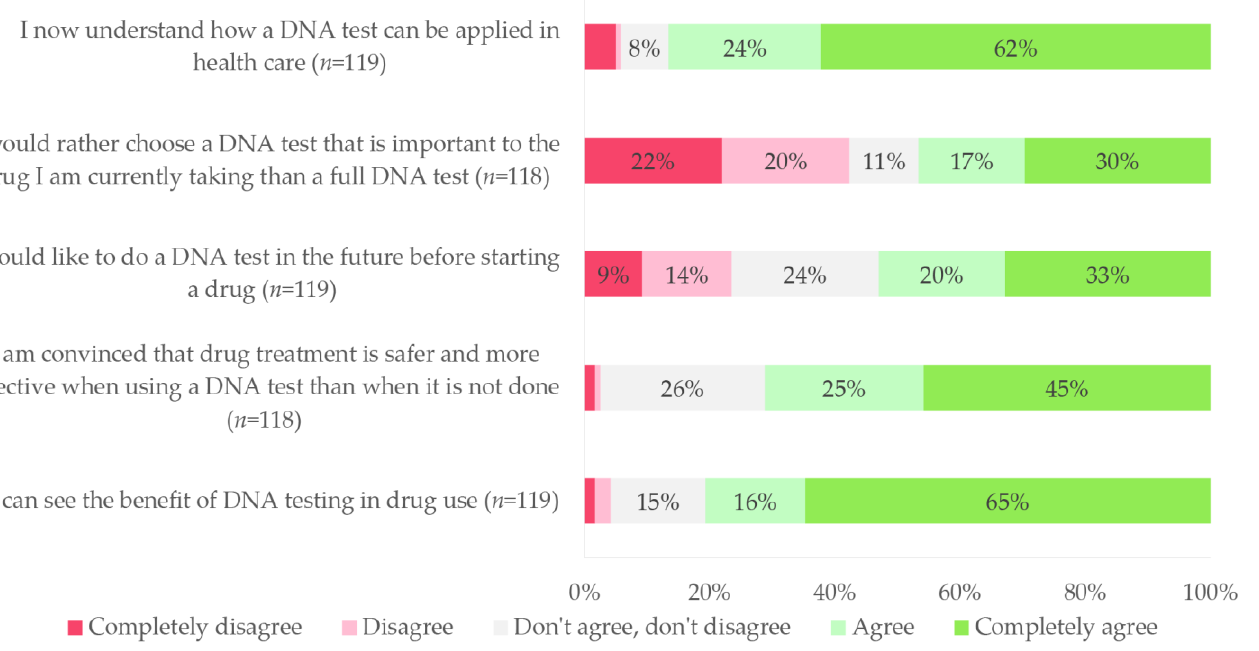
Figure 3. Patient survey results on the added value of pharmacogenetic testing. DNA test: pharmacogenetic test. Percentages may not add to 100% because of rounding.